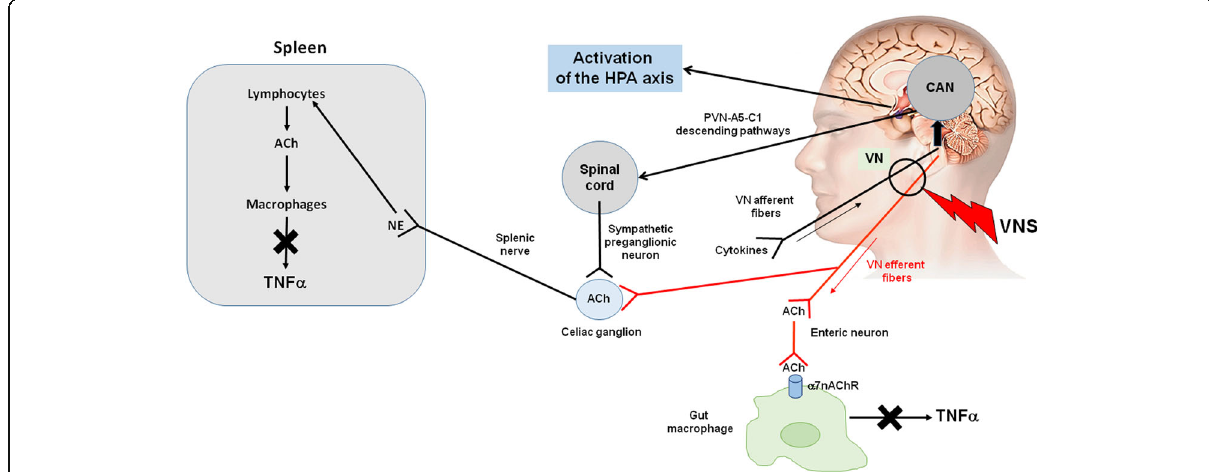
Fig. 1 Anti-inflammatory pathways of the vagus nerve. Adapted from reference (Bonaz et al., 2017). Ach, acetylcholine; CAN, central autonomic network; HPA axis, hypothalamic pituitary adrenal axis; NE, norepinephrine; TNF α , tumor necrosis alpha; VN, vagus nerve; VNS, vagus nerve stimulation; α 7nAChR, alpha7 nicotinic acetylcholine